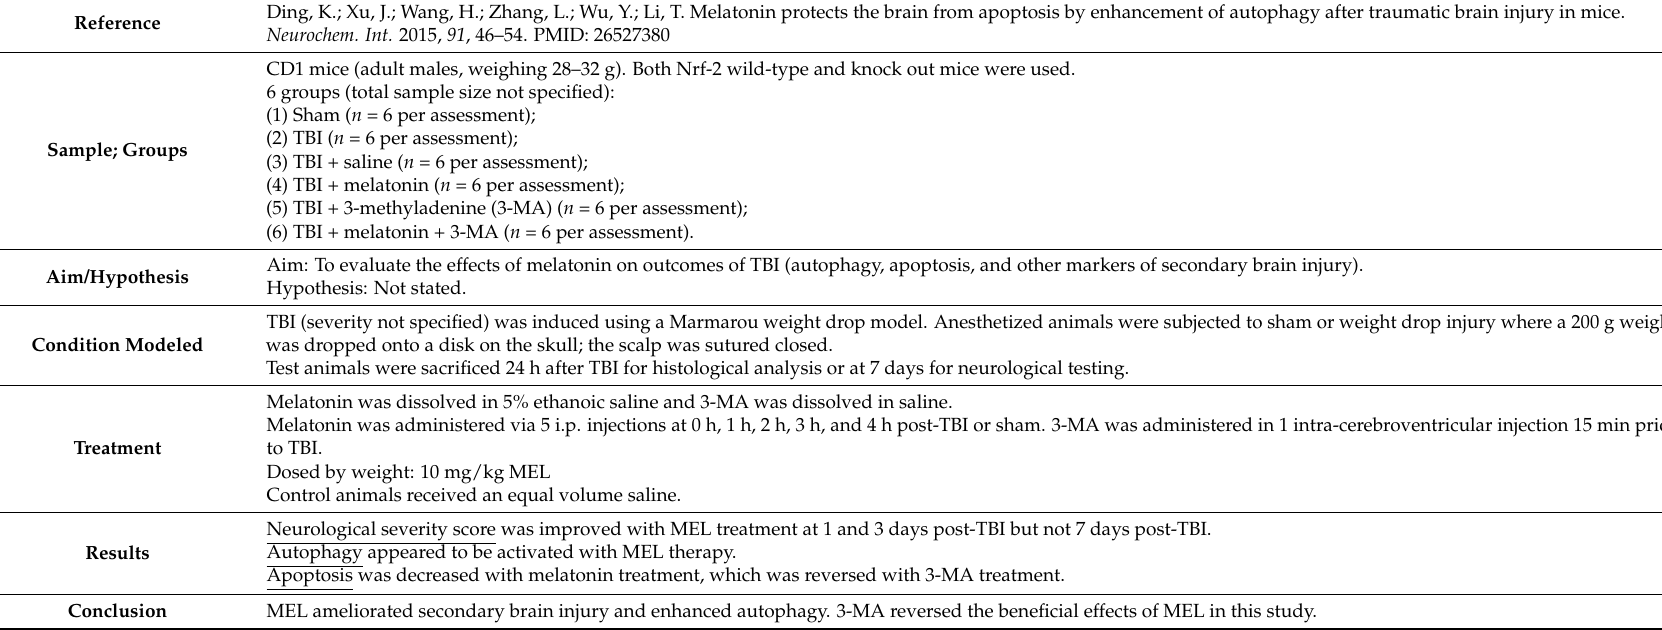
Table A16. Ding et al. (2015) Study